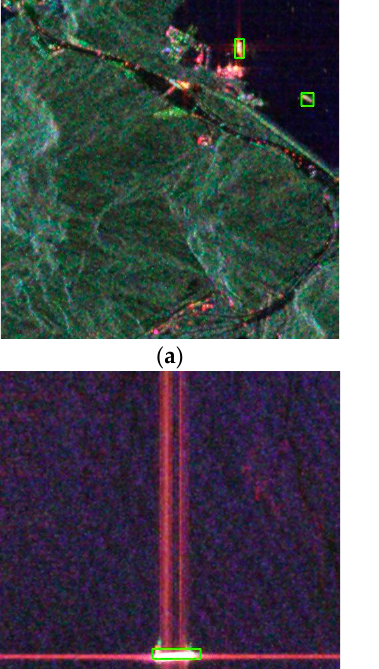
Table 1. Ship detection results (AP) with different input factors.